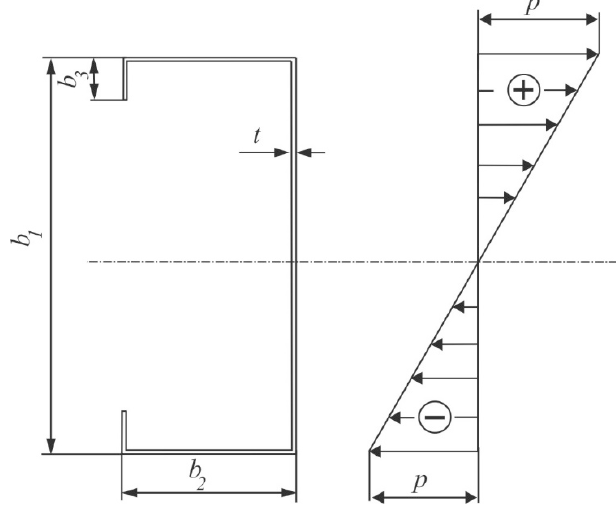
Figure 1. Cross-section of the lip channel. Table 1. Geometrical dimensions considered lipped channel (LC)-beams.